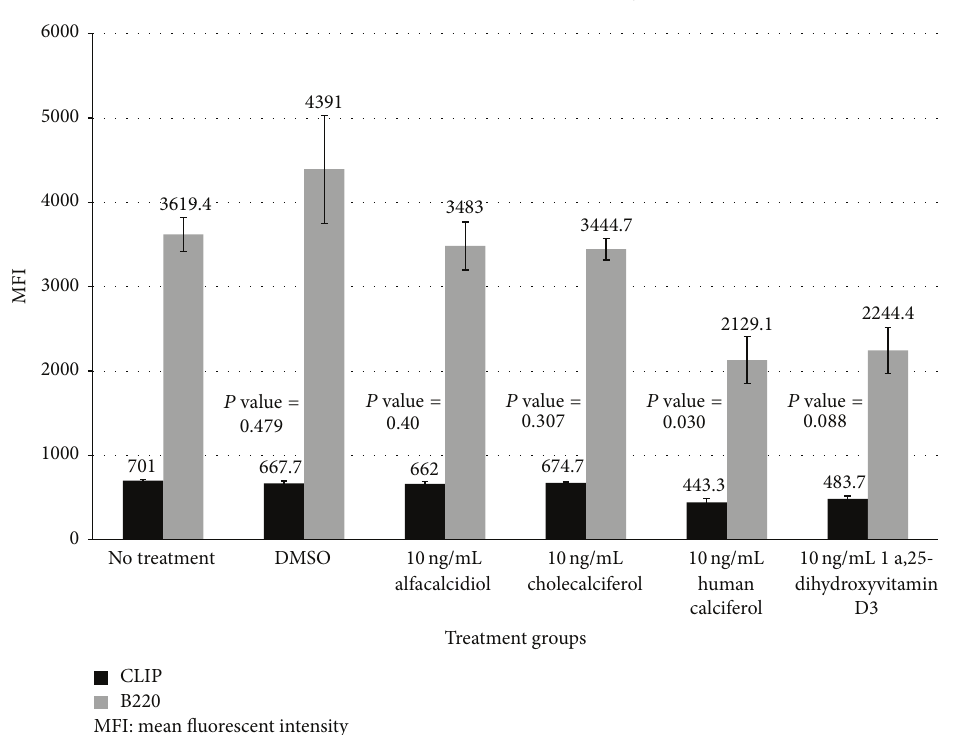
Figure 3: This bar graph also shows the effects of different vitamin D3 compounds at a concentration of 10ng/mL on the MFI of CLIP expression and CLIP + B220 subsets of B cells after TLR-activation. This graph compares the changes in MFI of CLIP and CLIP + B220 subsets of B cells 15 hrs after administration of different compounds of vitamin D3 versus no treatment or DMSO (control). These results suggest that exogenously produced bioactive 1,25(OH) 2 D3 may be needed in higher doses of activated vitamin D3 in order to reduce the level of CLIP expression on polyclonally activated B cells ( 𝑃 = 0.055 ). Administration of human calcitriol again resulted in most significant reduction in CLIP expression on polyclonally activated